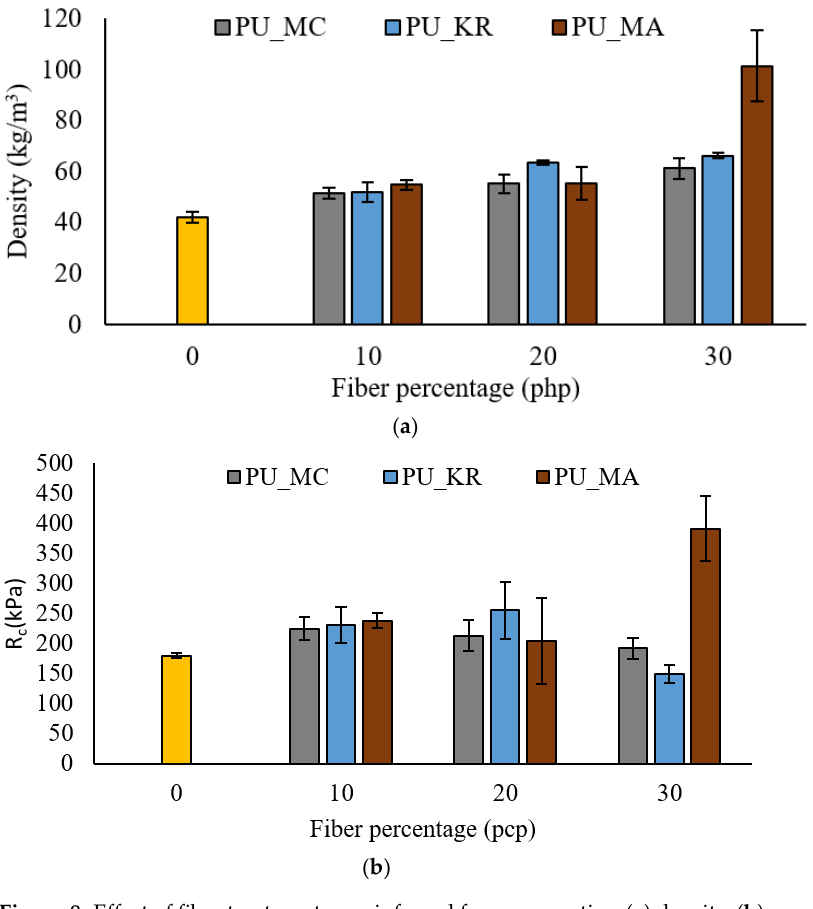
Materials 2022 , 15 , x FOR PEER REVIEW